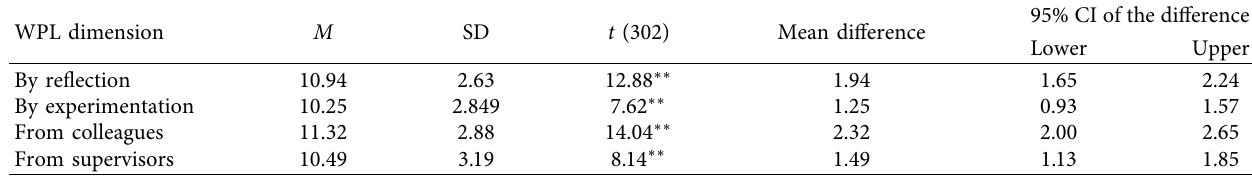
Table 3: One-sample t -test result of LPW in four dimensions.